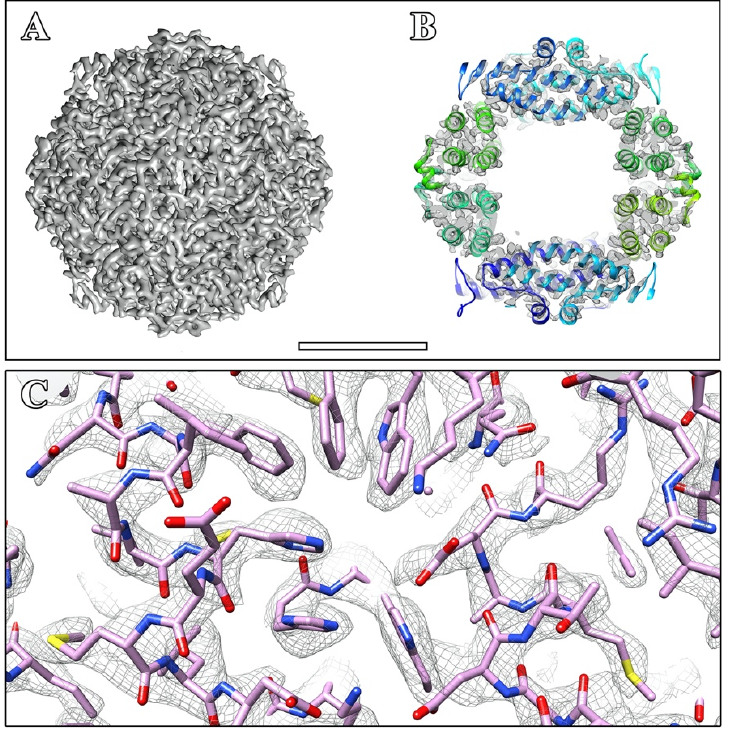
Figure A6. Cryo-EM map of Dps. ( A ) Dps surface; ( B ) slice through the center of Dps, PDB 1DPS; ( C ) high resolution cryo-EM map (EMD-14943) demonstrating ferroxidase center. Scale bar ( A , B ) is 4 nm.